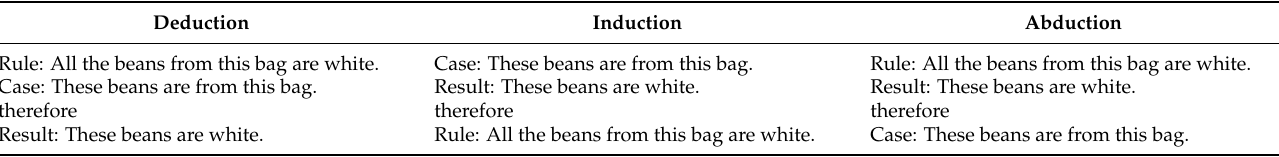
Table 1. Syllogistic characterisation of abduction, deduction, and